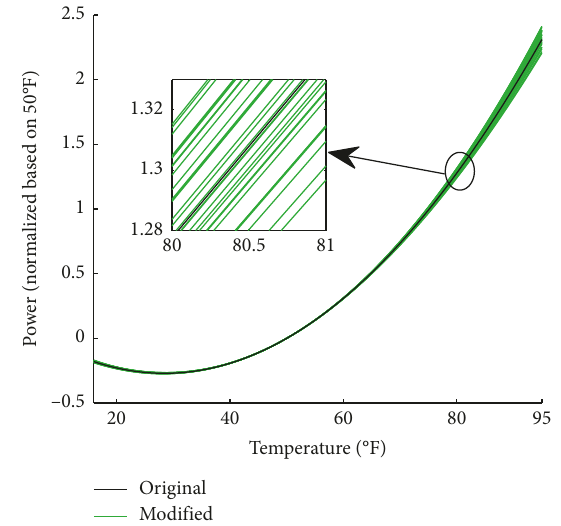
Figure 16: Modified power-temperature